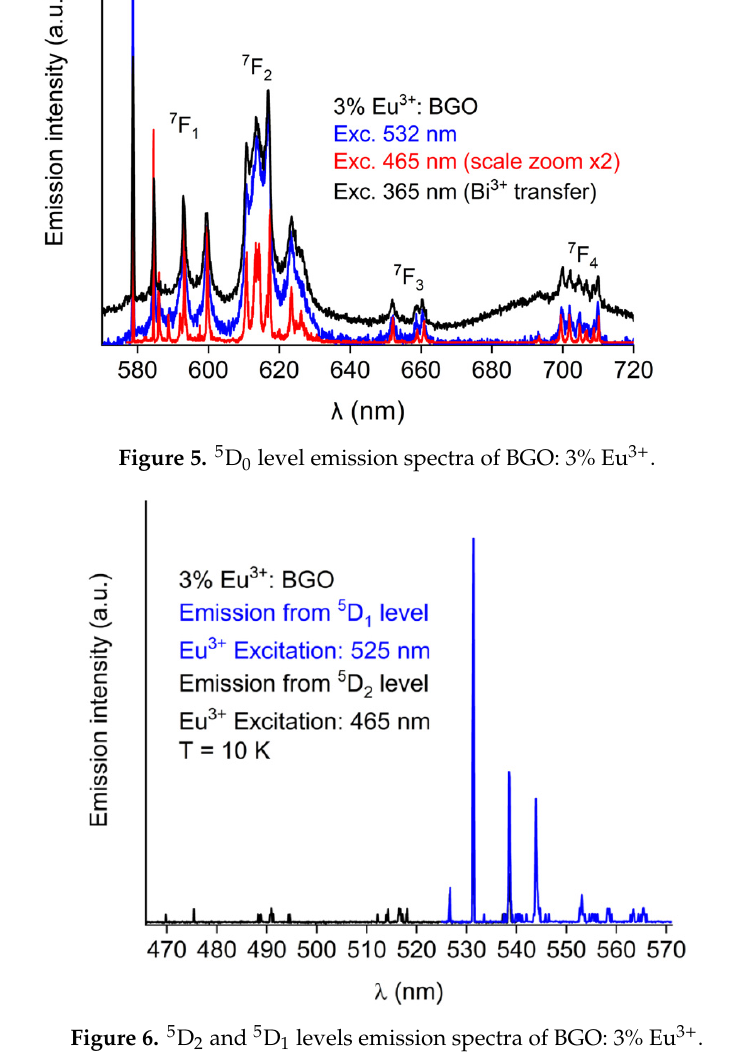
Figure 6. 5 D 2 and 5 D 1 levels emission spectra of BGO: 3% Eu 3+ .